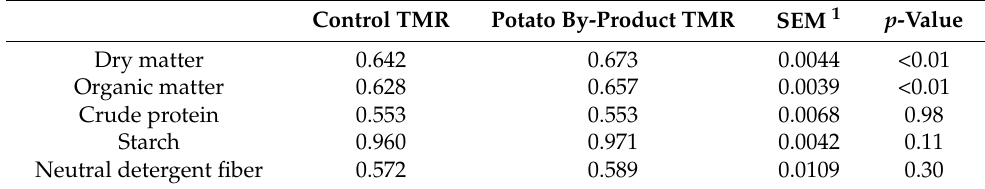
Table 5. Apparent total-tract digestibility (g/g) of dietary components of the total mixed ration (TMR) diets in the dairy cow feeding experiment (Experiment